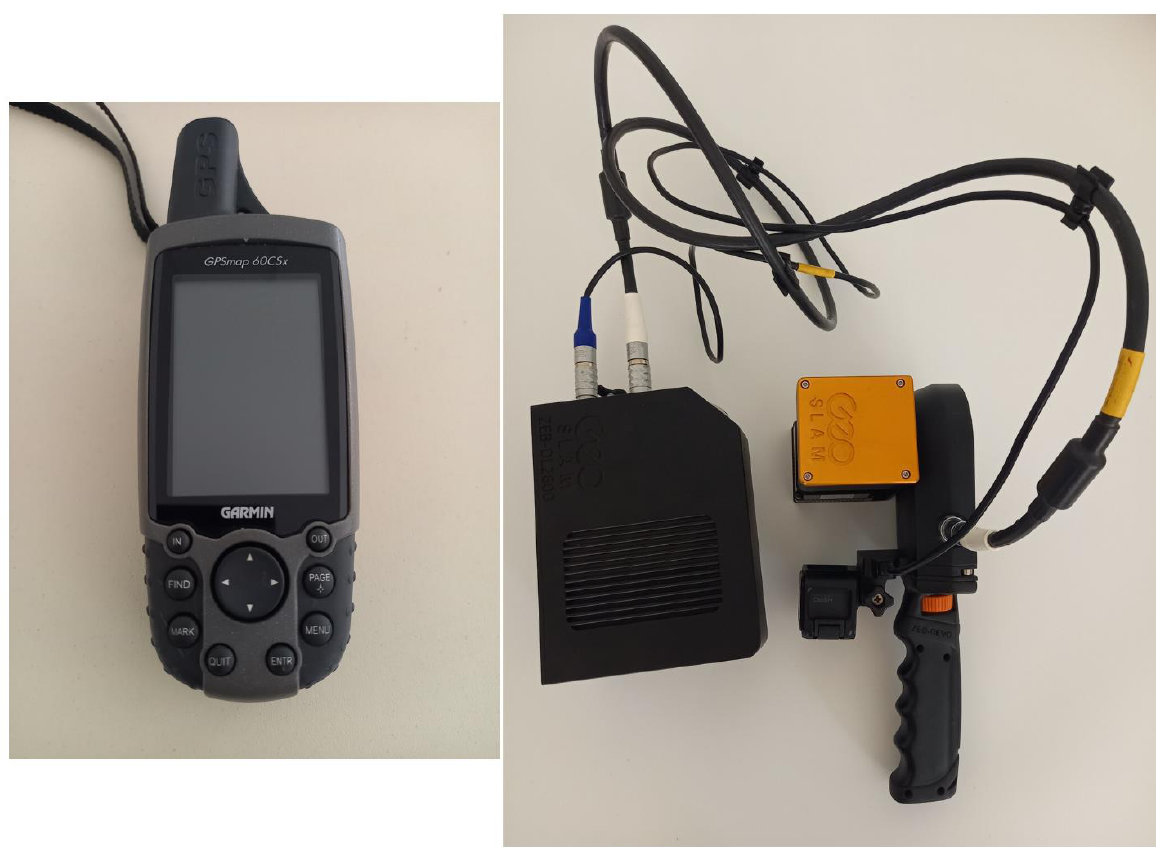
Figure A1. The two instruments used for measurements. Garmin GPSMap 60CSx (on the left ) and GeoSLAM-Zeb-Revo (on the right ).